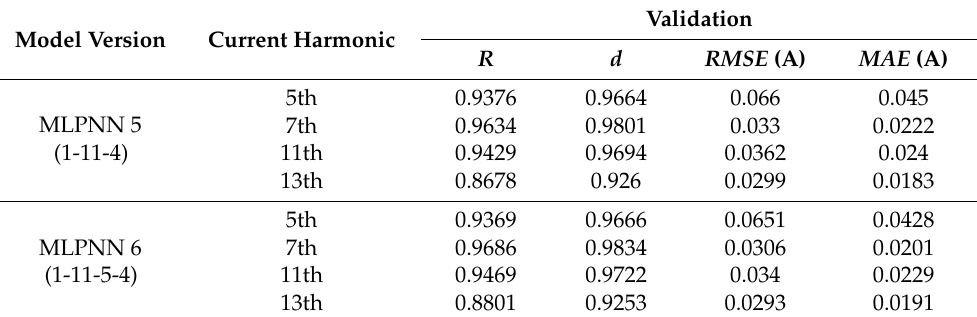
Table 7. Performance of the MLPNN with three input variables ( G , T amb , and t